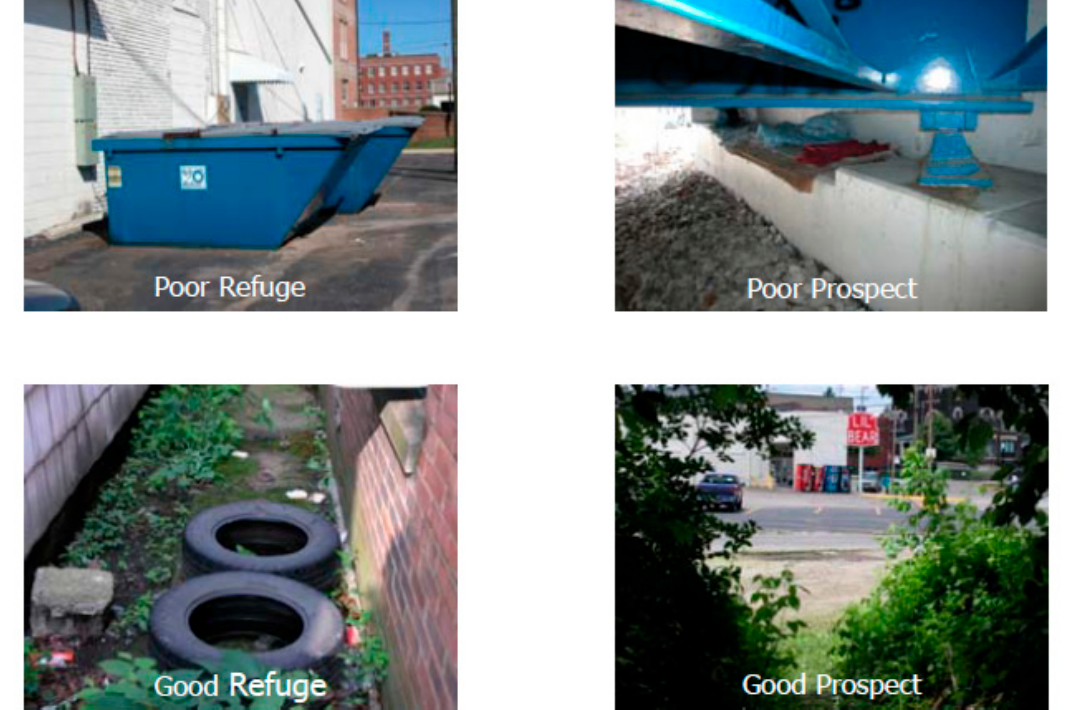
Figure 5. Examples of homeless sites offering good prospect or refuge. Photography: K. Sandin.